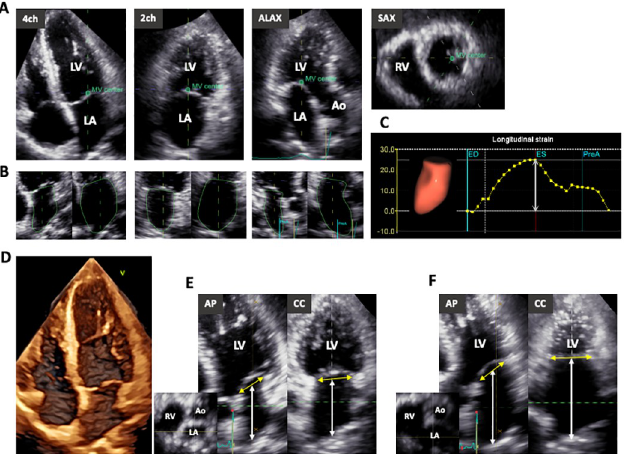
Fig 2. How to measure left atrial strain and length using 3D echocardiography. A: The center of the mitral valve was registered and the angle was changed so that dotted lines dissected the maximal LA length in three apical views extracted from 3DE datasets. B: Software determined the LA endocardial border in 3D space. C: LA longitudinal strain curve and a 3D cast of the left atrium. D: Cropped view of 3DE datasets. E and F: Under the guidance of the short axis view of the left atrium, anterior-posterior and commissure-commissure views showing full visualization of LA longitudinal distance were obtained, from which we measured the LA longitudinal distance between the center of the mitral annular plane and the LA roof at end-diastole and end-systole. 3DE, three-dimensional echocardiography; Ao, aorta; AP, anterior-posterior view; CC, commissure-commissure view; ED, end-diastole; ES, end-systole; MV, mitral valve; LA, left atrium; LV, left ventricle; RV, right ventricle; PreA, pre-atrial contraction.